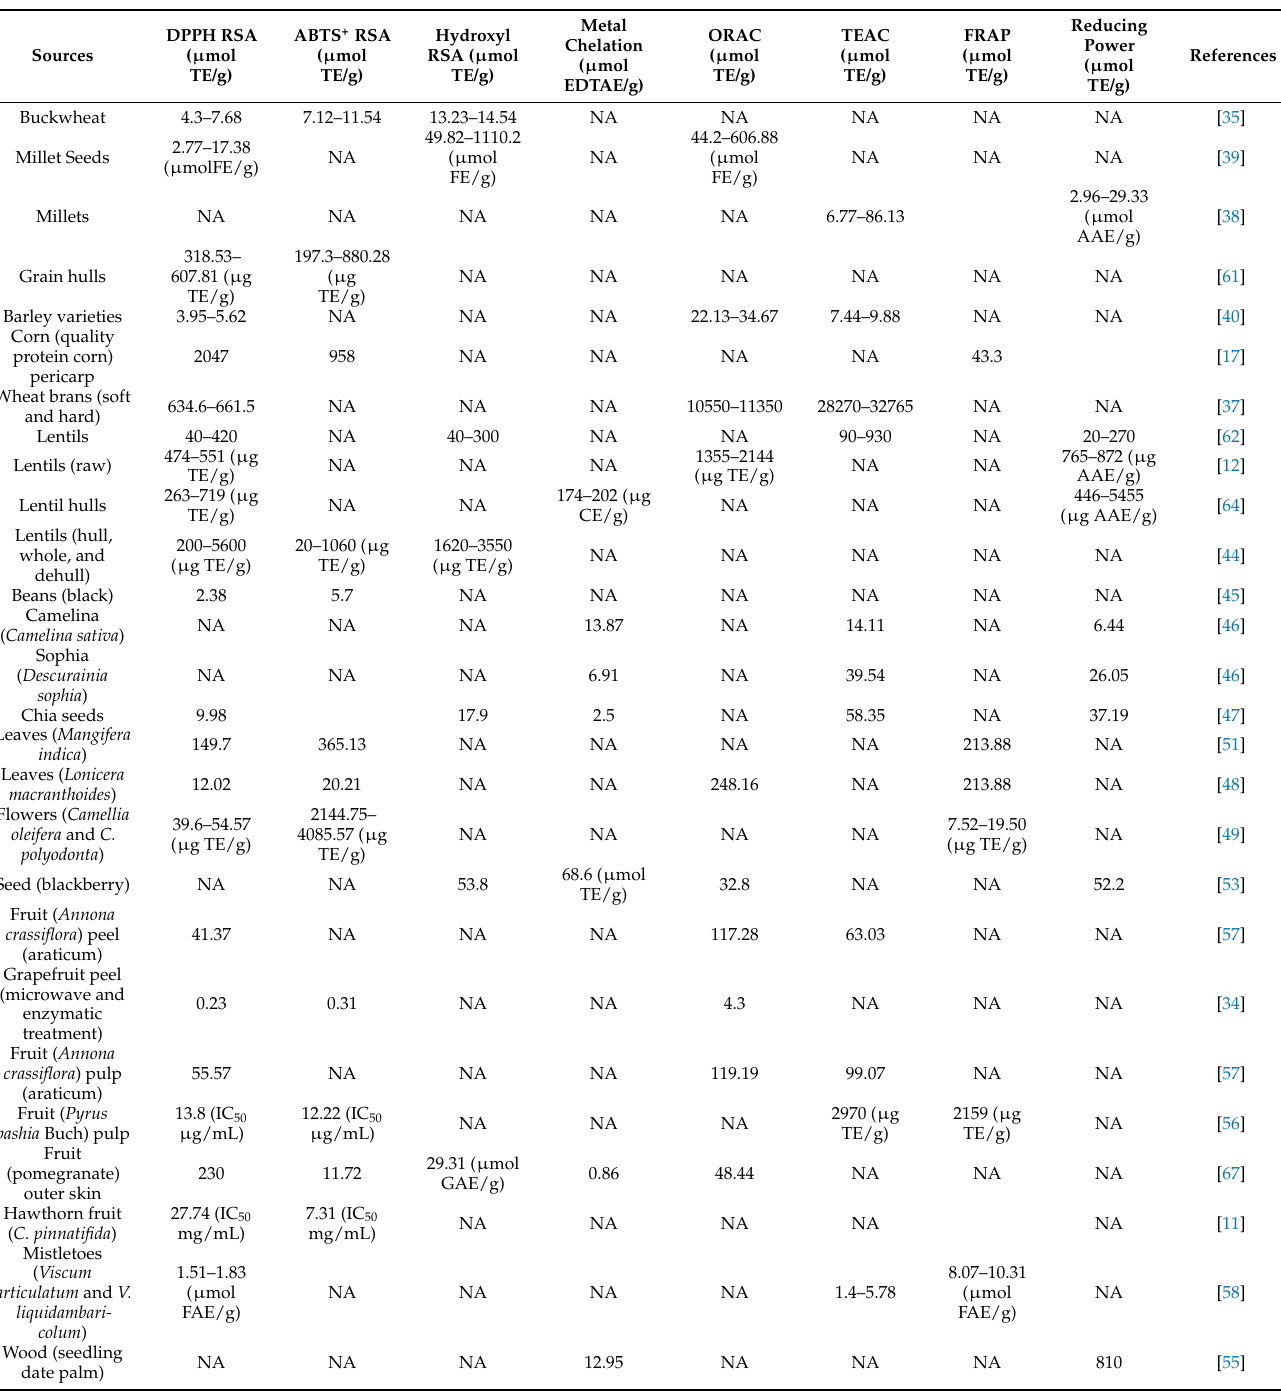
Table 4. Antioxidant potential of IBPs obtained from various